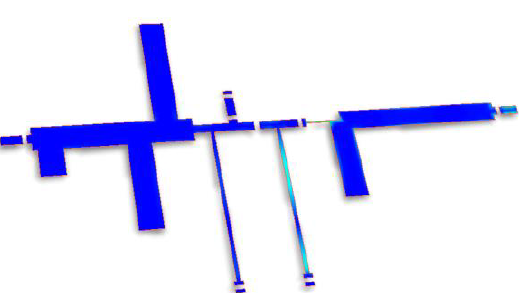
Fig. 24. EM-circuit excitation result @ 2 nd harmonic